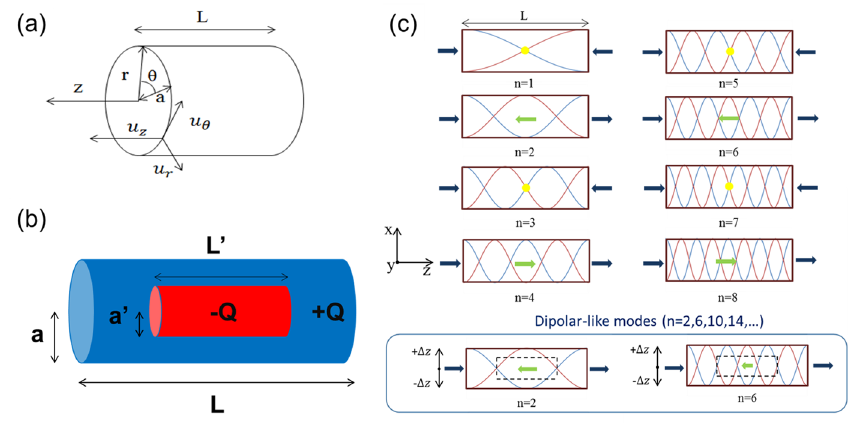
Figure 1. Longitudinal standing waves in a nano-cylinder. ( a ) Coordinate of a nano-cylinder; L: length of cylinder; a: radius of cylinder. θ θ u u u , , are displacement of r, , z . ( b ) Schematic showing the core (red part) r z and shell (blue part) structure of a nano-cylinder with different charges. a is the radius of the whole cylinder, and L is the length of the whole cylinder. a’ is the radius of core, and L’ is the length of core; Dimension ratio = L’/L = a’/a . ( c ) Displacement of the longitudinal standing waves in a nano-cylinder. Brown and light blue curves represent the distribution of displacement when both ends have largest displacement. Dark blue and light green arrows indicate the direction of displacement at ends and center of the cylinder,